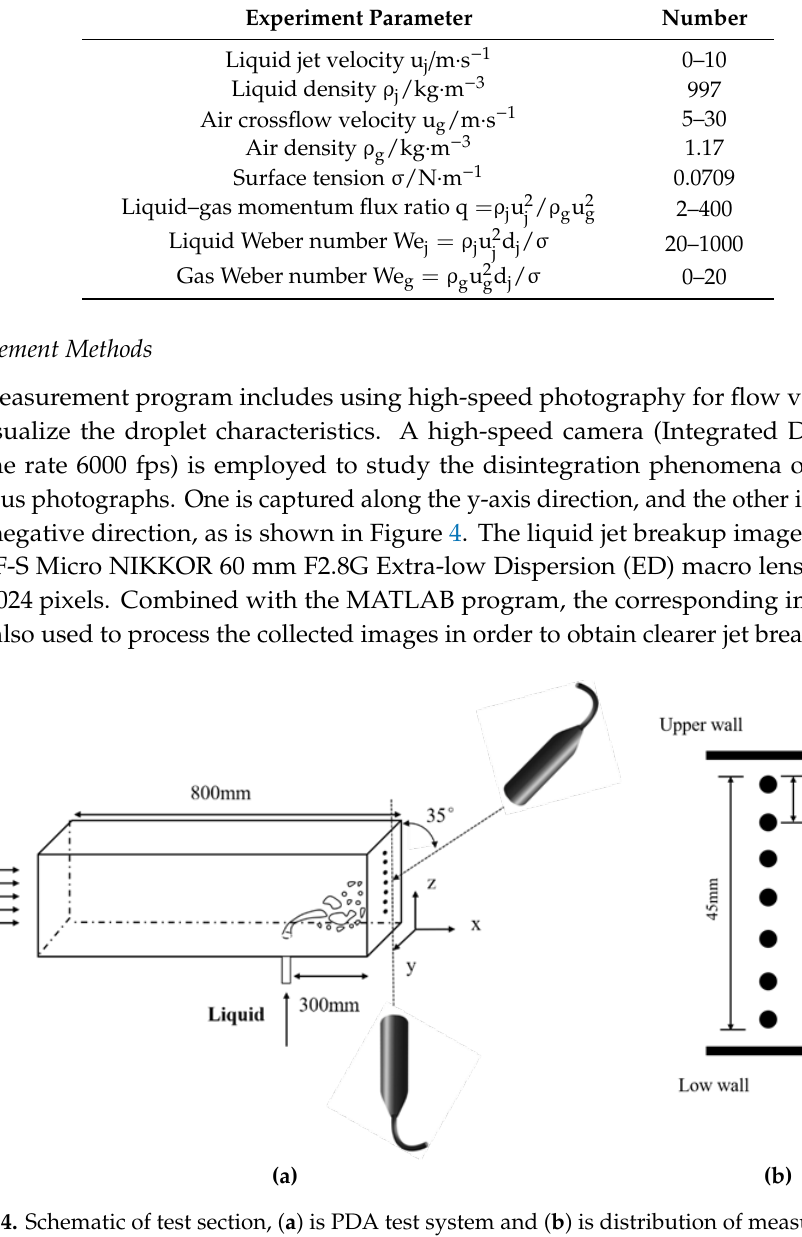
Table 1. Experimental conditions.